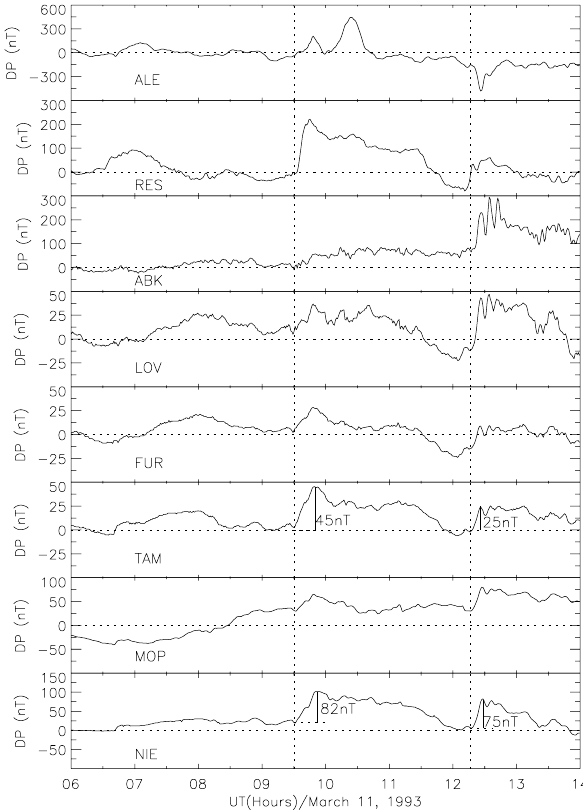
Fig. 2. Variation of H-component disturbances (DP) at polar cap (ALE, RES), high latitude (ABK, LOV), middle latitude (FUR), low latitude (TAM, MOP) and dip-equator